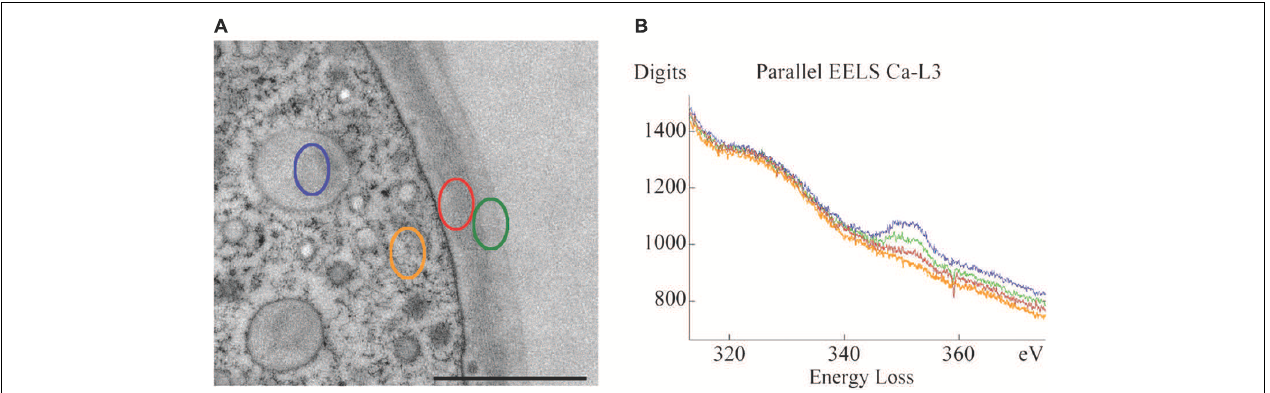
FIGURE 2 | Transmission electron microscopy (TEM) micrograph (A) of cell periphery and primary cell wall of M. denticulata with highlighted measurement sites of EEL spectra (scale bar is 1 µ m). (B) EEL spectra acquired at the Ca L 2 , 3 -edge, indicating calcium binding capacities of different cell components after doping with calcium acetate. Outer side of primary wall (green) has higher calcium binding capacity than inner side (red). Mucilage vesicle (blue) reveal highest calcium binding capacity, the cytoplasm (orange) lowest. Reprinted with permission from Eder and Lütz-Meindl (2008), Copyright © 2008 Royal Microscopical